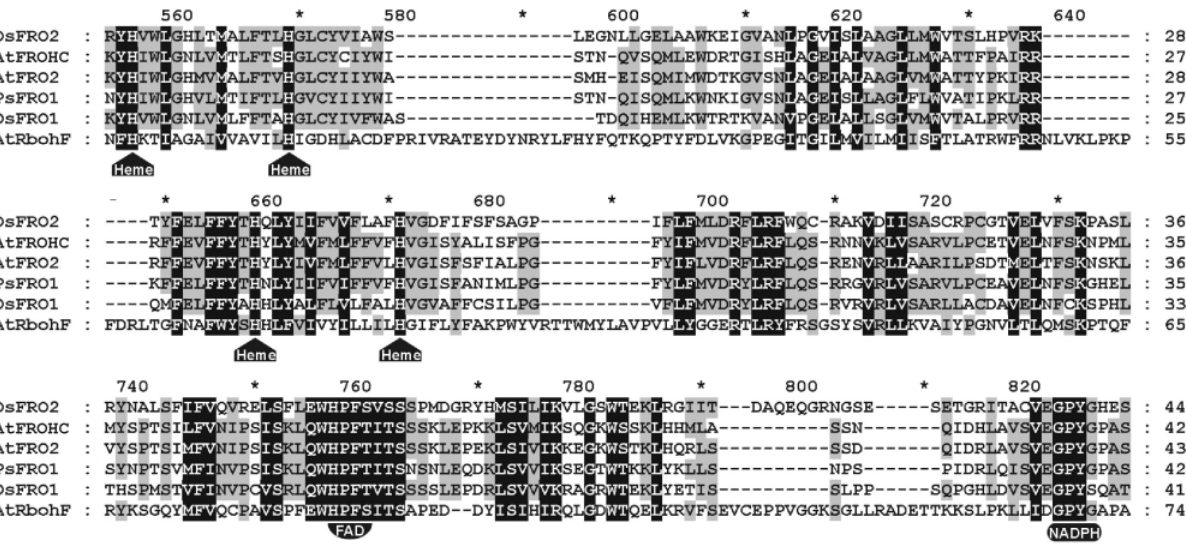
Figure 3 - Conservation of amino acids around the prosthetic binding sites in the FRO family. The multiple alignment was performed using ClustalW al- gorithm. Only the central parts of the proteins are shown. The four heme-coordinating histidine (H) residues and the dinucleotide binding motifs (FAD, HPFT and NAPH, GPYG) are indicated under the block of alignments in the respective positions. Accession numbers of nucleotide sequences and corre- sponding predicted OsFRO proteins are shown in Table 2. Accession numbers to the other proteins are as follows: AtFrohC: AAB72168; AtFRO2: CAA70770; PsFRO1: AAK95654; AtRbohF ( Arabidopsis thaliana Respiratory burst oxidase F): BAA28953. Black color indicates regions in the align- ment with 100% similarity and gray color indicates regions with at least 60%